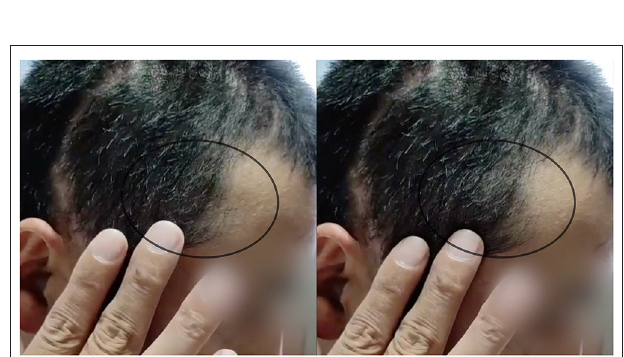
FIGURE 3 | The appearance of subcutaneous effusion in physical examination. Black circle: the increasingly bulging scalp under pressing. (Consent for publication has taken from this